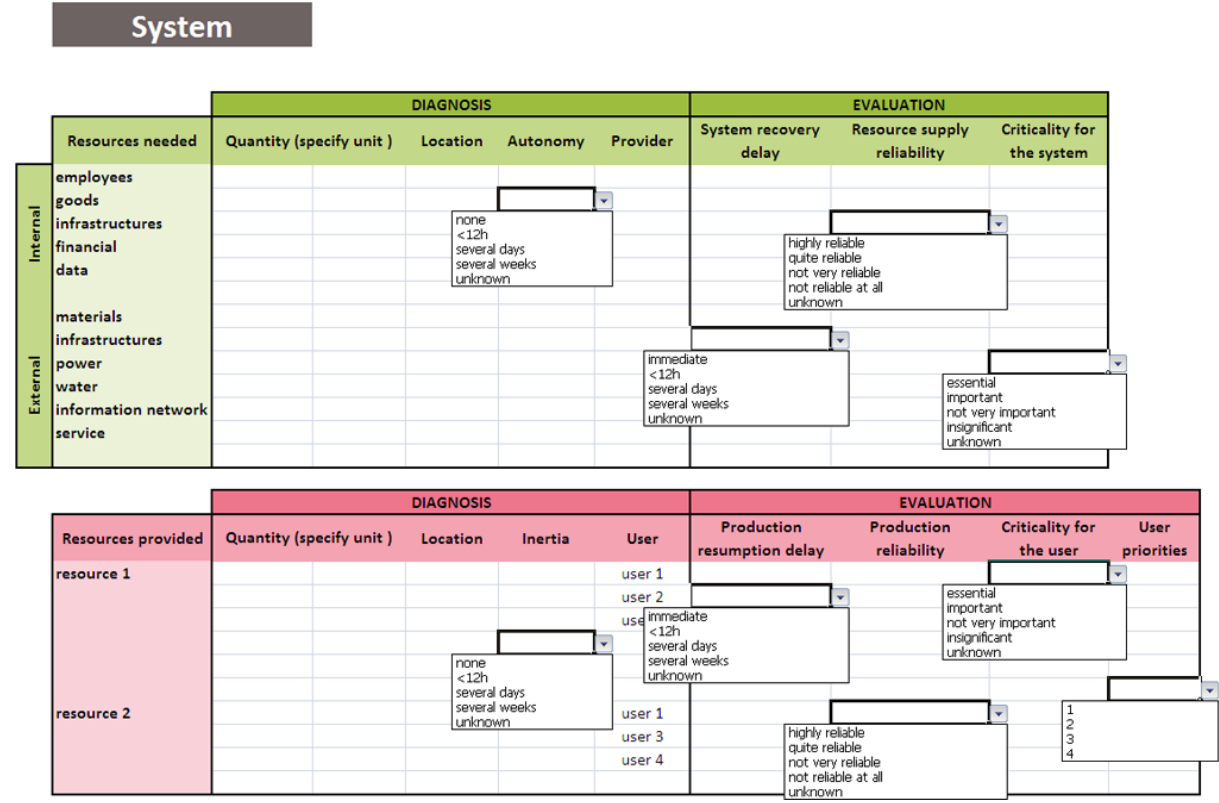
Fig. 2. Auto-diagnosis to be completed by the network